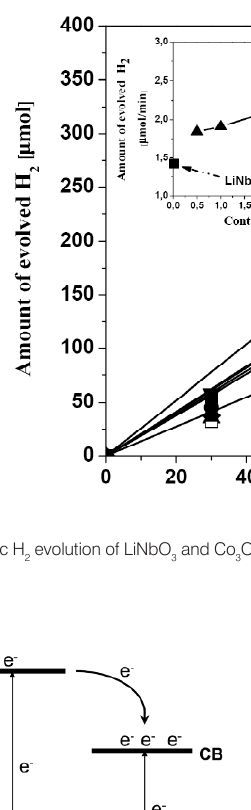
(a), 0.5 wt.% -Co/LiNbO 3 (f). 3